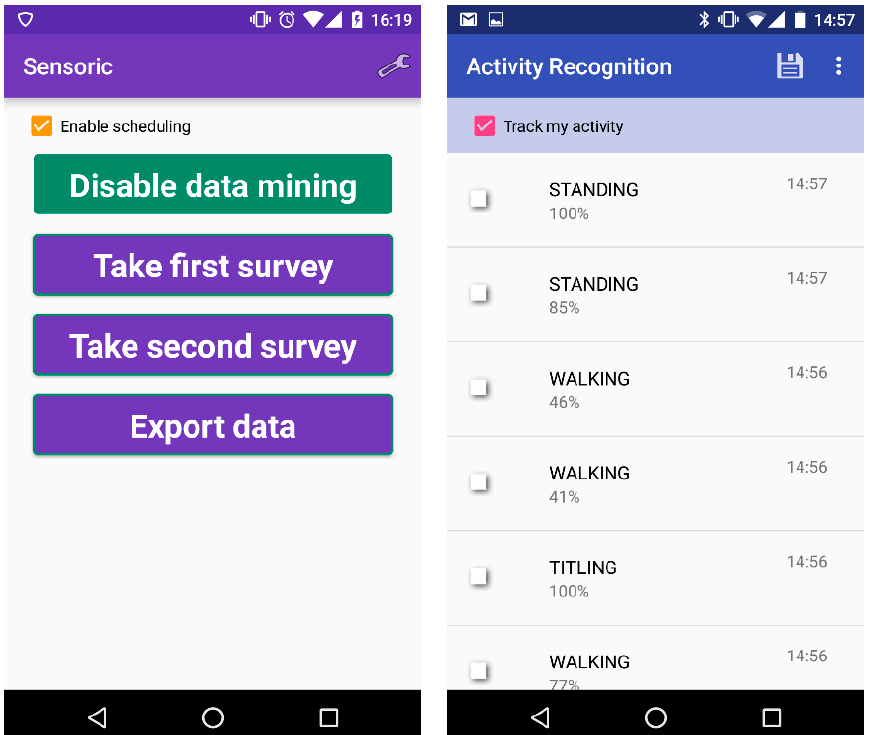
Figure 5. Sensoric application for collecting smartphone data and android application for activity recognition based on the GAR API. ( left ) main menu; ( right ) activity recognition subscreen.